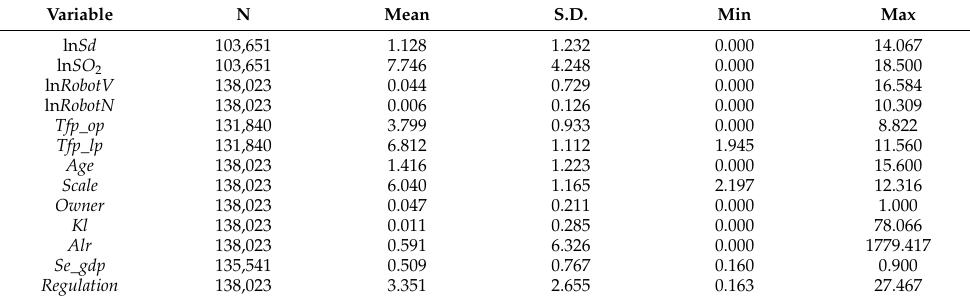
Figure 5. Industrial robot inventory in major countries from 2001 to 2019.